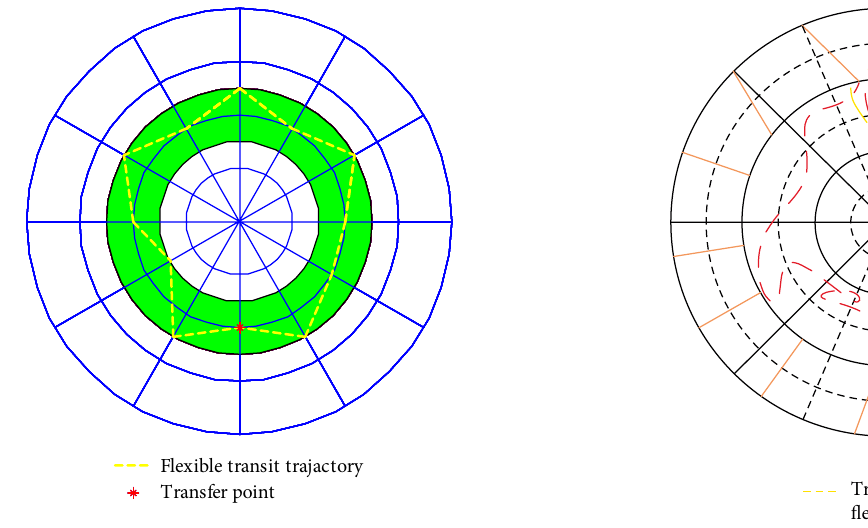
Figure 1: Proposed flexible transit system in a radial pattern.